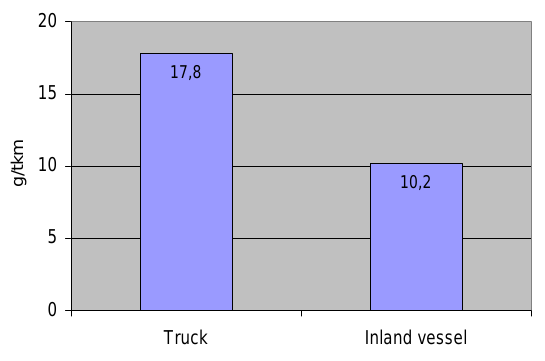
Fig 8. Specific energy consumption of transport modes, in EU-25, in 2000